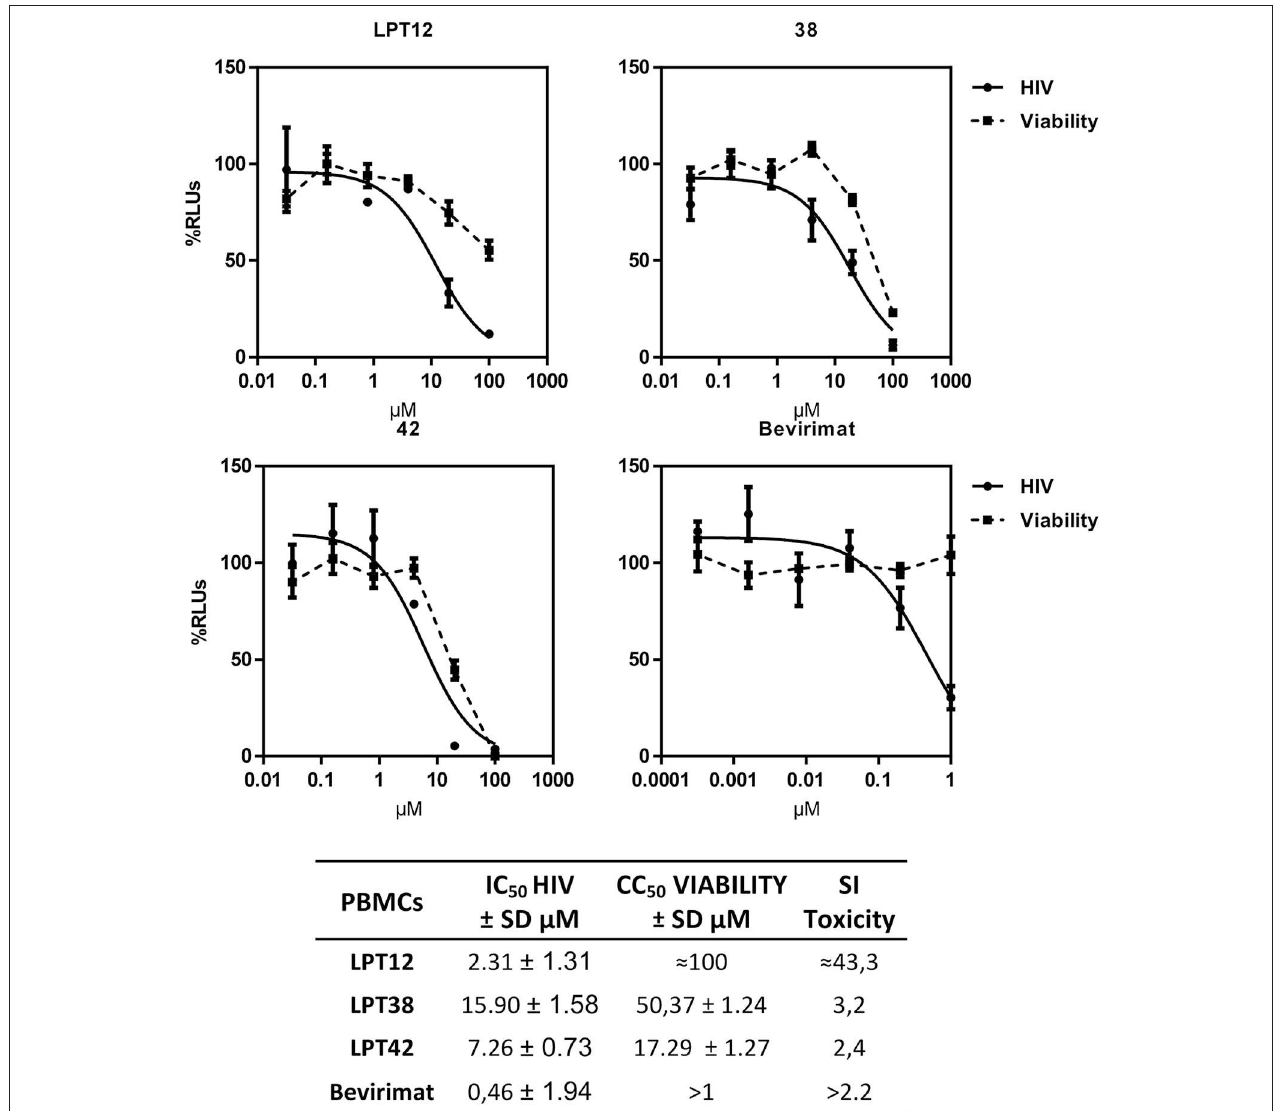
FIGURE 11 | Dose response inhibition curves of HIV-1 ( HIV) replication in primary human lymphocytes (PBLs) by LPT12, LPT38, LPT42, and bevirimat. Viability was measured in mock infected cultures ( Viability). Results are shown as percentage of RLUs as compared to an untreated control. IC 50 values were calculated with GraphPad Prism software, using non-linear regression analysis (Log inhibitor vs. response). SD, Standard deviation; SI toxicity, Specificity index toxicity (CC 50 /IC 50